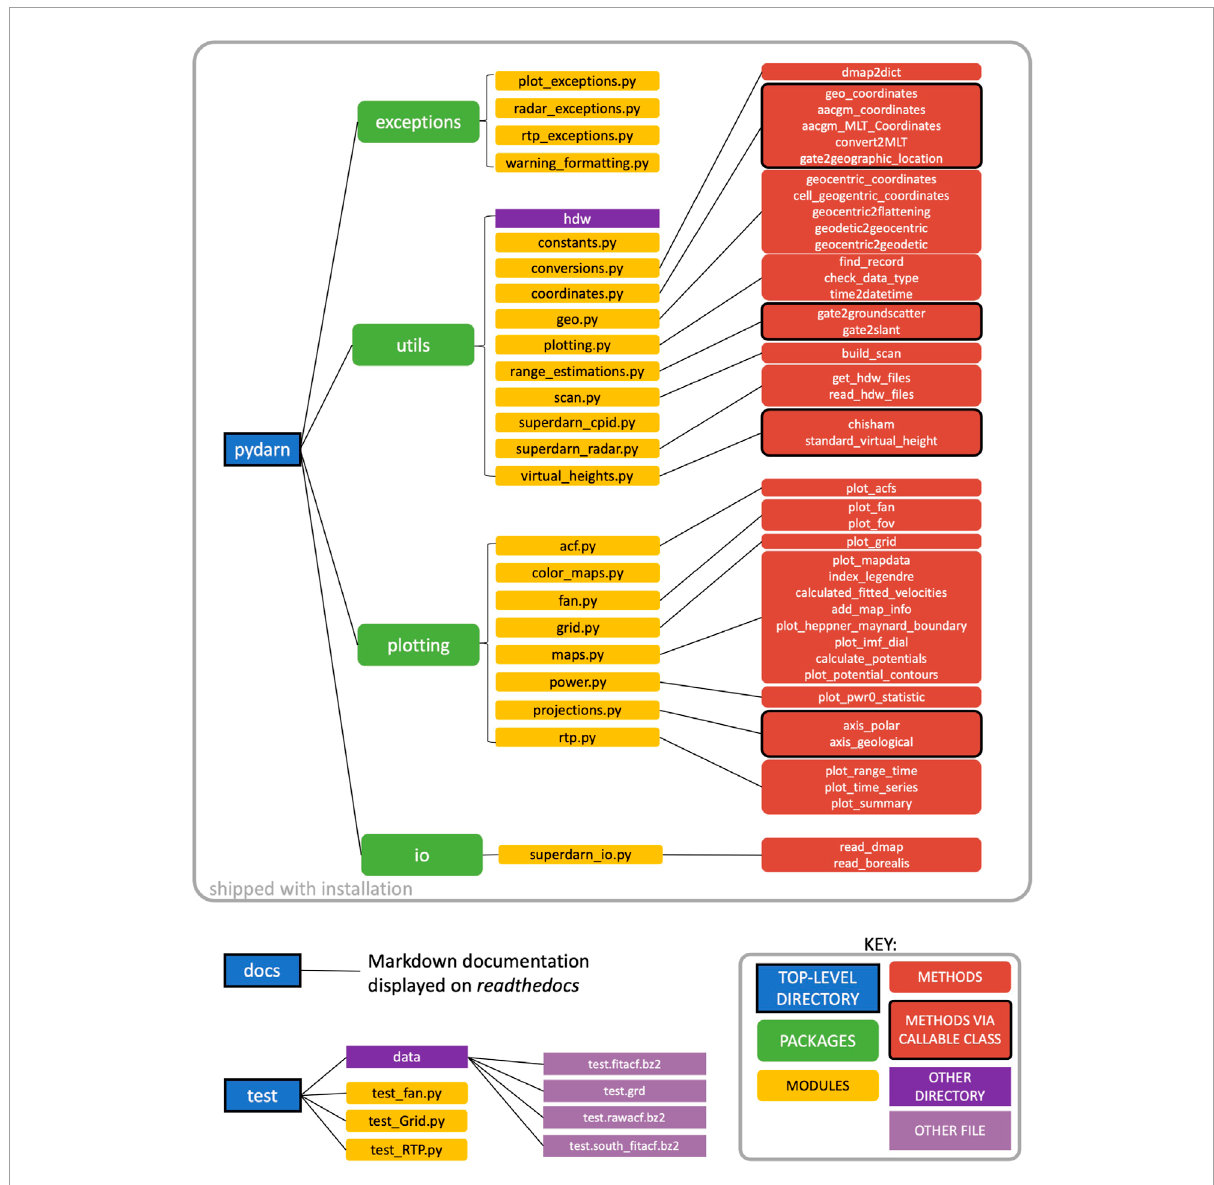
FIGURE 1 Layout and structure of the pyDARN v3.0.0 library, including the packages, modules and some of the more commonly used methods that are shipped with the installation. Also shown are other peripheral directories that are useful in development and discussion.